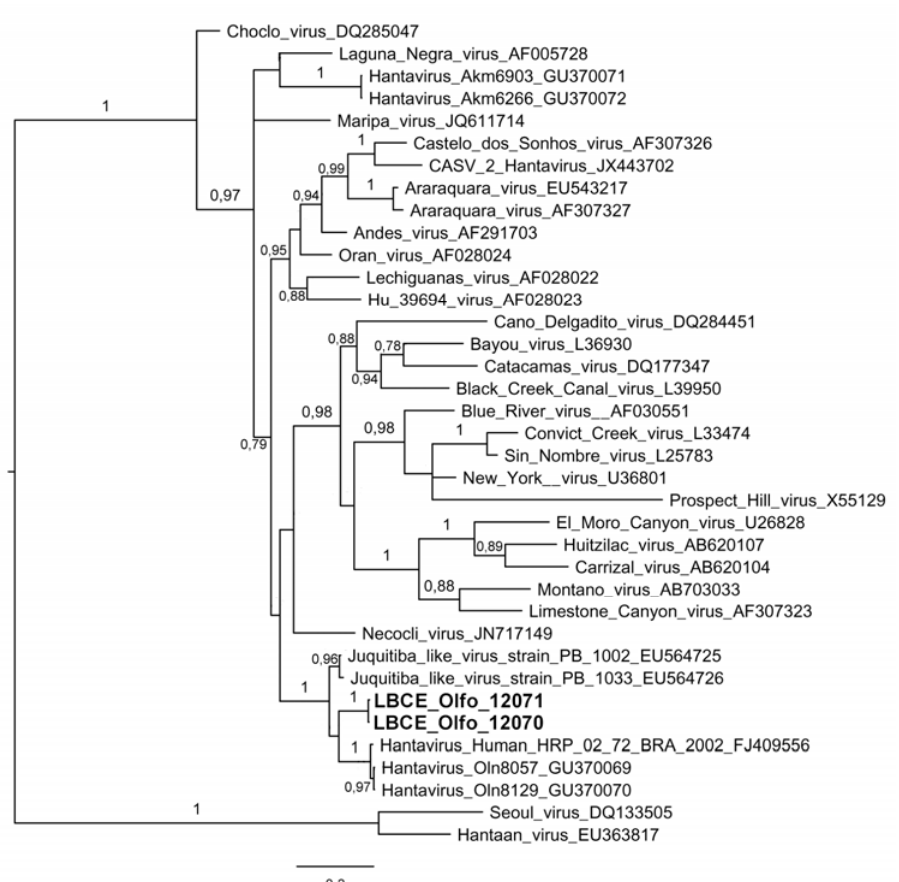
Figure 3. Phylogenetic relationships among hantaviruses based on a Bayesian analysis of genetic distances generated from comparisons of the glycoprotein gene (Gc) partial sequences (425 nt). The scale bar indicates a sequence divergence of 0.3. The numerical value at the node indicates the posterior probability (pp) replicates that supported the interior branch. The branch labels include GenBank ® accession number and viral species or